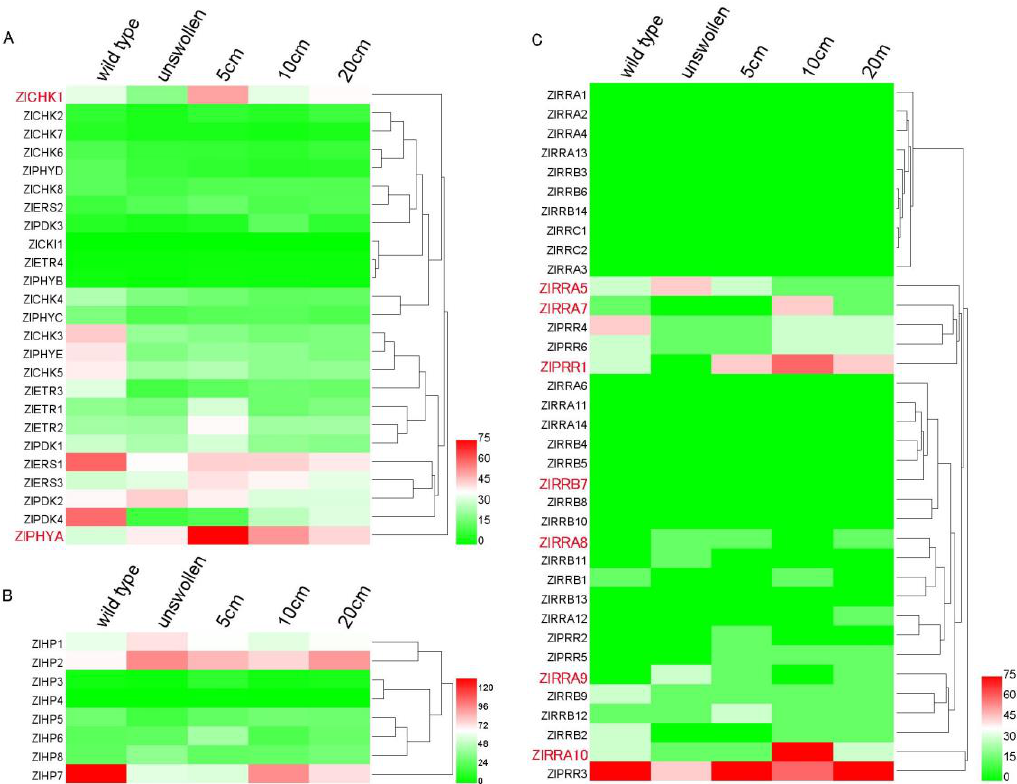
Figure 6. Heatmap showing the expression of ZlHK(L)s ( A ), ZlHPs ( B ), and ZlRRs ( C ) in Z. latifolia . The expression levels of genes are presented using transcripts Per Million reads (TPM) values and the color scale are shown at the top of heat map. Green represents low expression and red represents strong expression.